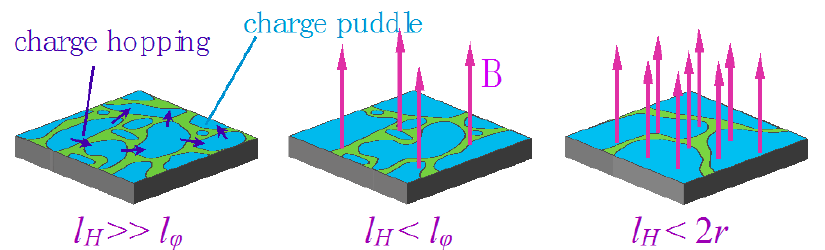
Figure 7. The formation of charge puddles in the AI and charge hopping between them. The red arrows show the perpendicular magnetic fields B . At the intermediate magnetic field l H < ~ l φ , the size of the charge puddles becomes enlarged. When the field is so large that l H < 2 r , the quantum interference is totally destroyed.